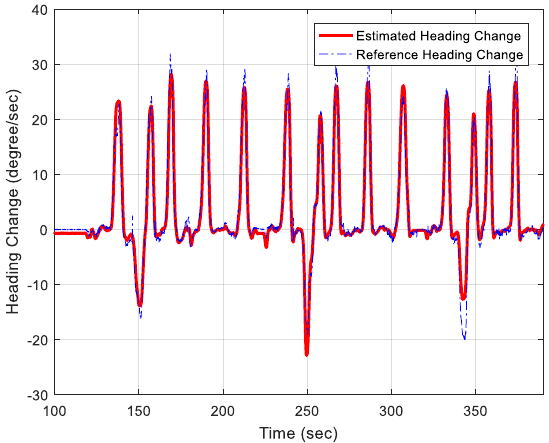
Figure 11. CPD change of heading versus the reference heading change